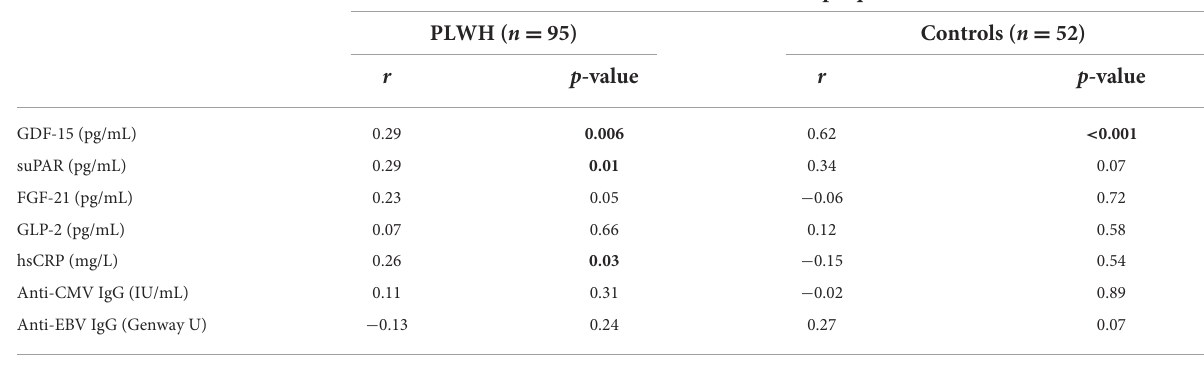
TABLE 3 Correlations between clinical measures and total plaque volume or low-attenuation plaque volume in people living with HIV and uninfected controls. Biomarker